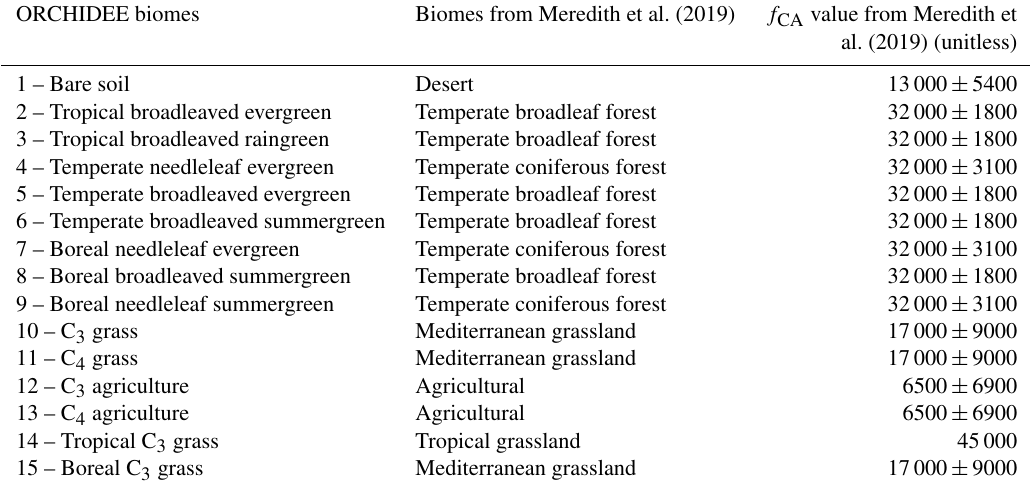
Table A1. Carbonic anhydrase enhancement factor adapted to ORCHIDEE biomes.